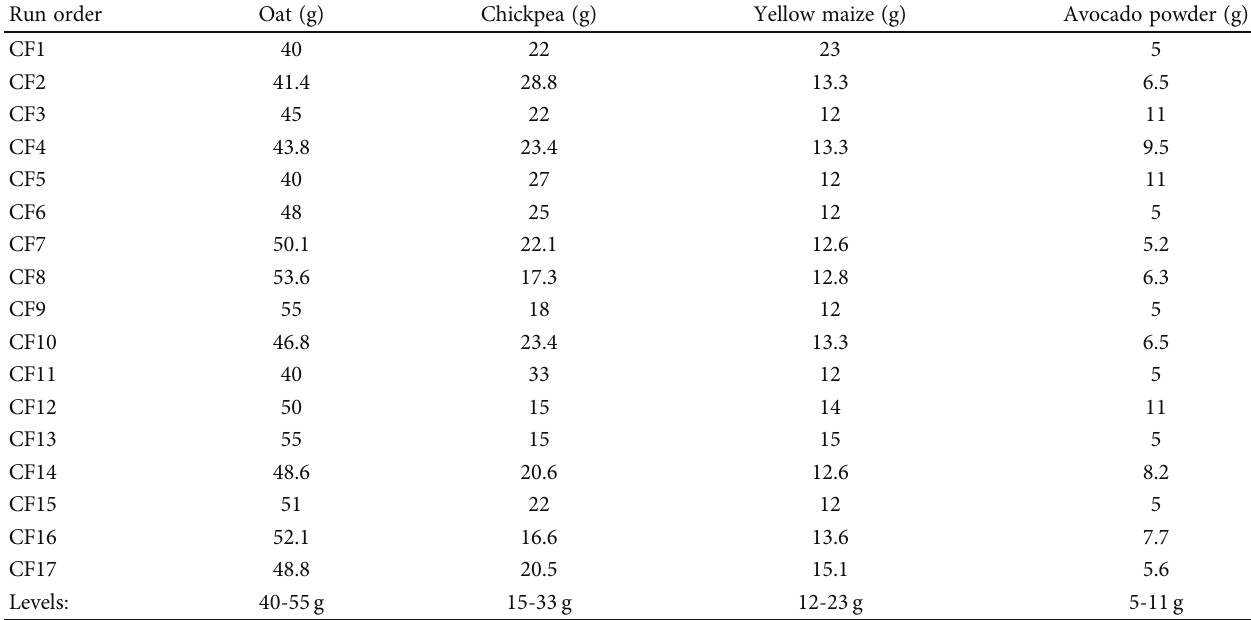
Table 1: Mixture design for the formulation of complementary foods (CF).